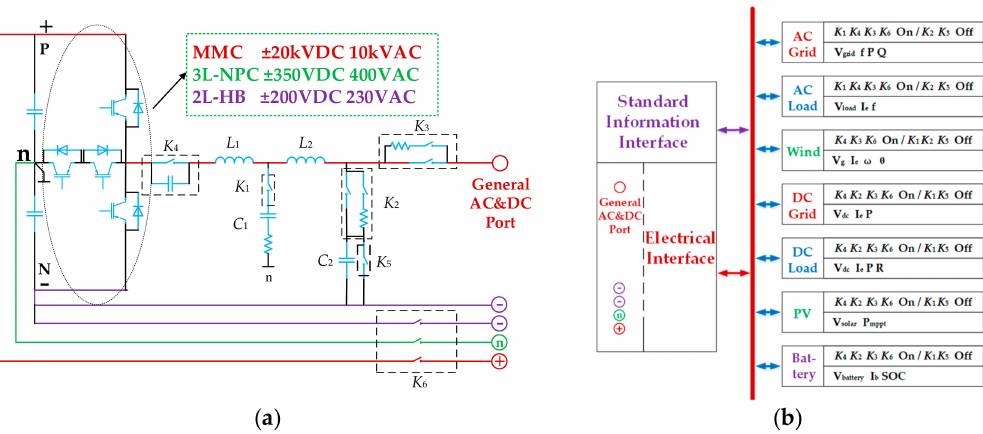
Figure 1. ( a ) Topology of the alterable structure power router; ( b ) Interfaces and applications.